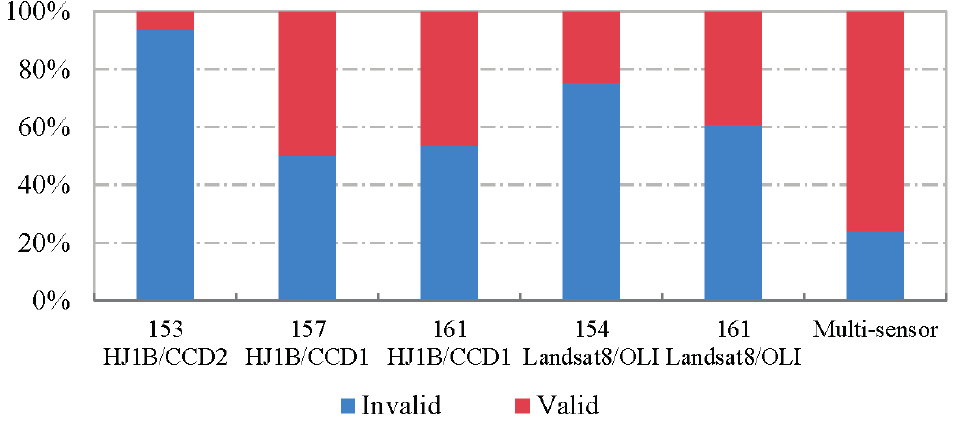
Figure 11. Distribution of valid LAI inversions during the period of 1 to 10 June